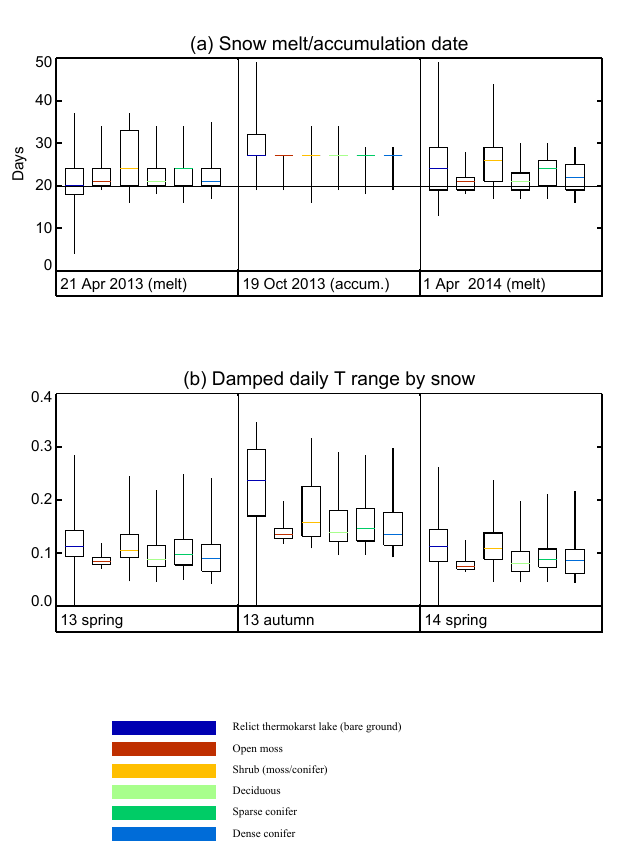
Figure 7. (a) Differences in snow melt (or accumulation) dates for different land cover types for the spring of 2013 (after 21 April 2013), autumn of 2013 (after 19 October 2013), and spring of 2014 (after 1 April 2014). (b) Damping rate for daily temper- ature range averaged over snow-covered days having continuous measurements (i.e. without missing or interrupted cable data) for the 50-day period following the respective start date of the